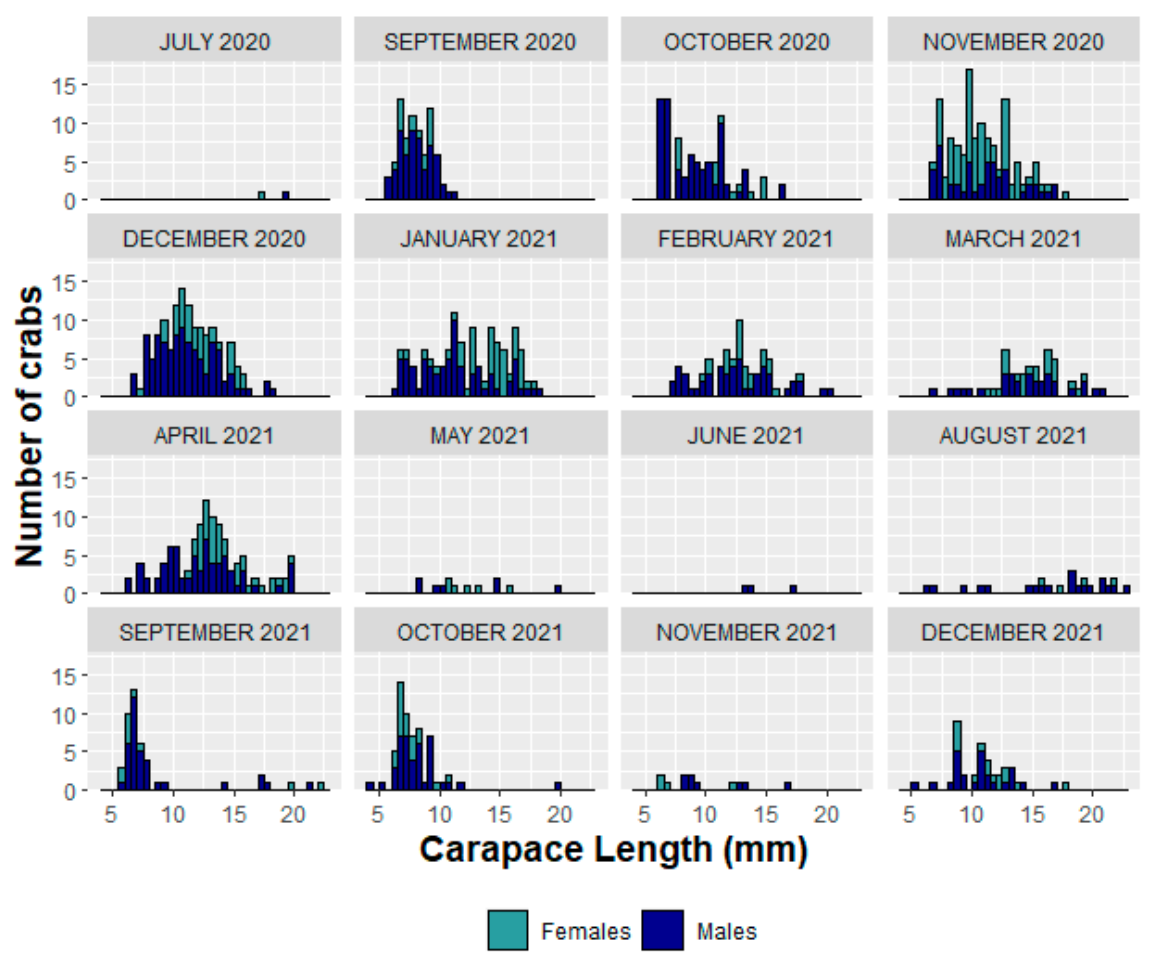
Figure 3. Monthly carapace length distribution of Percnon gibbesi caught in intertidal areas of Gran Canaria between July 2020 and December 2021. No significant differences (ANOVA, p > 0.05) were found in the length distribution of crabs between the three sampled areas, but there were significant differences between sexes. The CL, CW, and BW show that, on average, female nimble spray crabs are heavier and larger than males (Table 1). The Wilcoxon test showed that females had higher CW (W = 99,029, N1 = 650, N2 = 349, p < 0.0001, Figure 4 and CL (W = 99,434, N1 = 650, N2 = 349, p <0.0001, Figure 4) than males. Similarly, females also had a higher BW compared to males